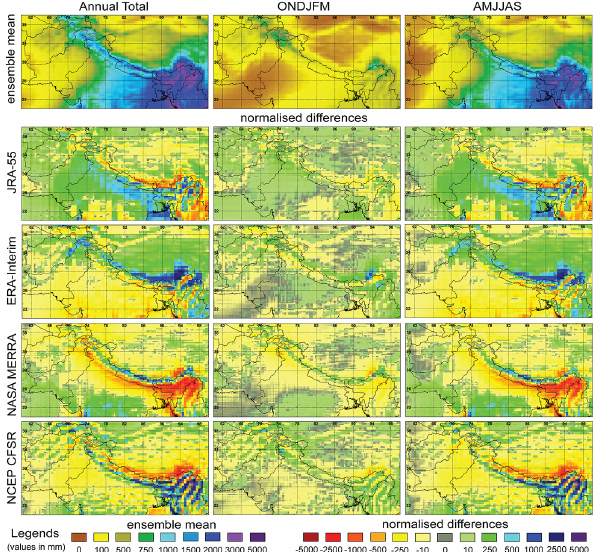
Figure 2. Ensemble precipitation climatology and normalised com- parison of individual contributions from reanalyses used in this study. ONDJFM is the abbreviation for the period from October to March, referred to regionally as “rabi”. AMJJAS is the abbrevi- ation for the period from April to September, referred to regionally as “kharif”.